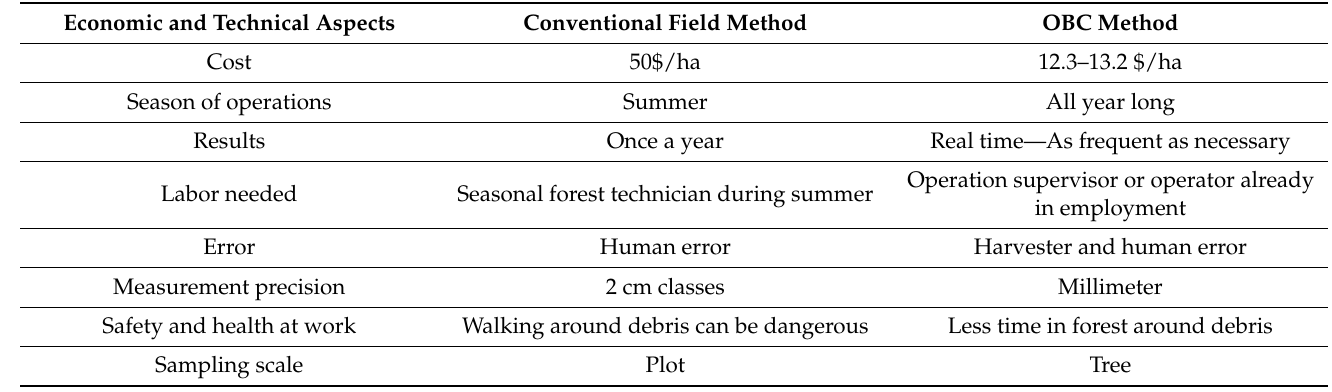
Table 5. Summary of exploratory comparison of technical